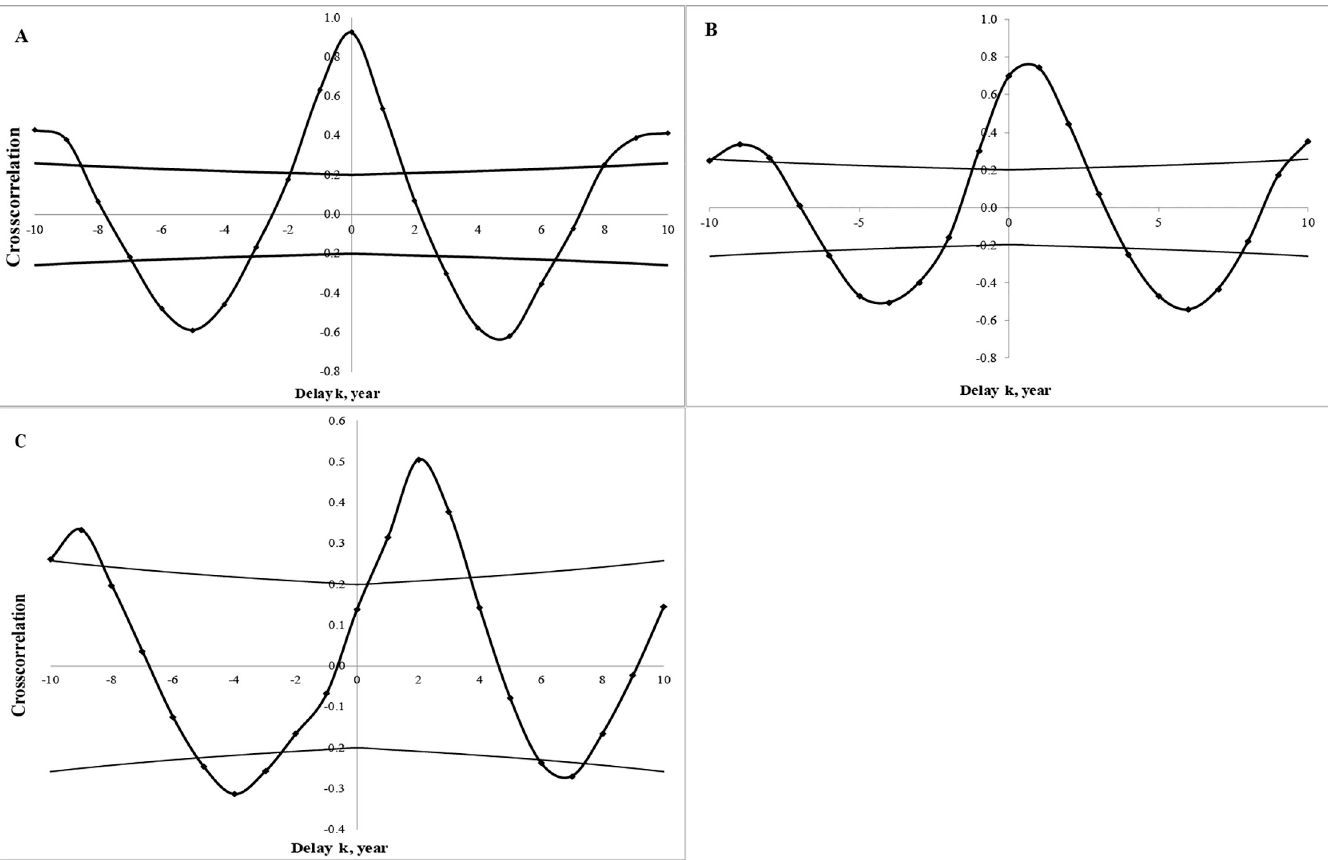
Fig 4. The cross-correlation function between time series data of forest defoliation (ha) for Novosibirsk oblast. The shift of function indicates the temporal delay in the north-east direction: for Karasuk and Kupino districts (a), Karasuk and Krasnozerskiy districts (b), and Karasuk and Kujbyshev districts